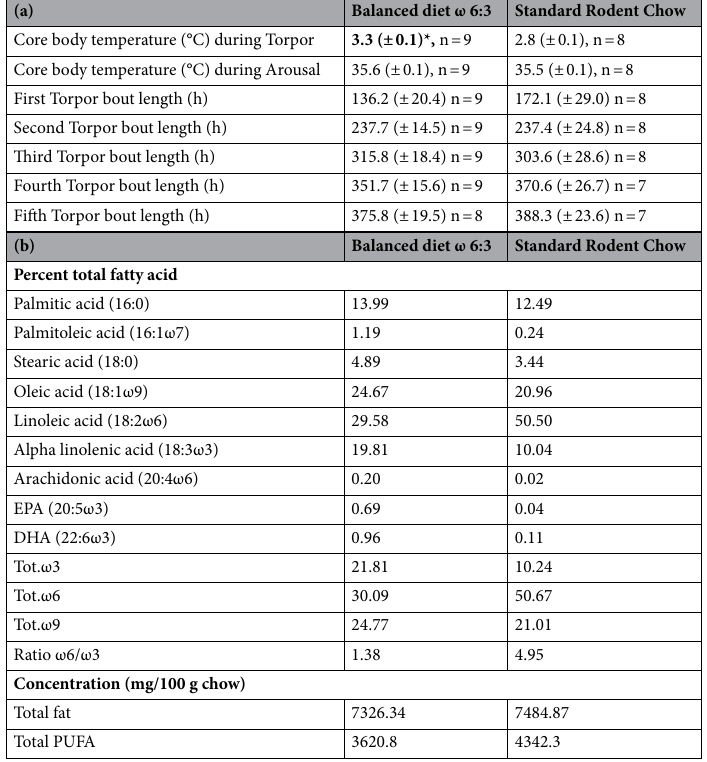
Table 1. Balanced Diet increases core body temperature in torpid AGS . (a) Hibernating core body temperature is significantly higher in Balanced Diet fed AGS (*p = 0.038, t-test, n = 8–9), but diet did not influence arousal core body temperature or torpor bout length. Data shown are mean ± SEM. (b) Fatty acid composition of Balanced Diet (Lab Diet, 9GU5) and Standard Rodent Chow (Mazuri, #5663). Data shown are percent of total fatty acid, except total fat and total PUFA are mg/100 g chow. Full fatty acid composition is listed in Supplemental Table